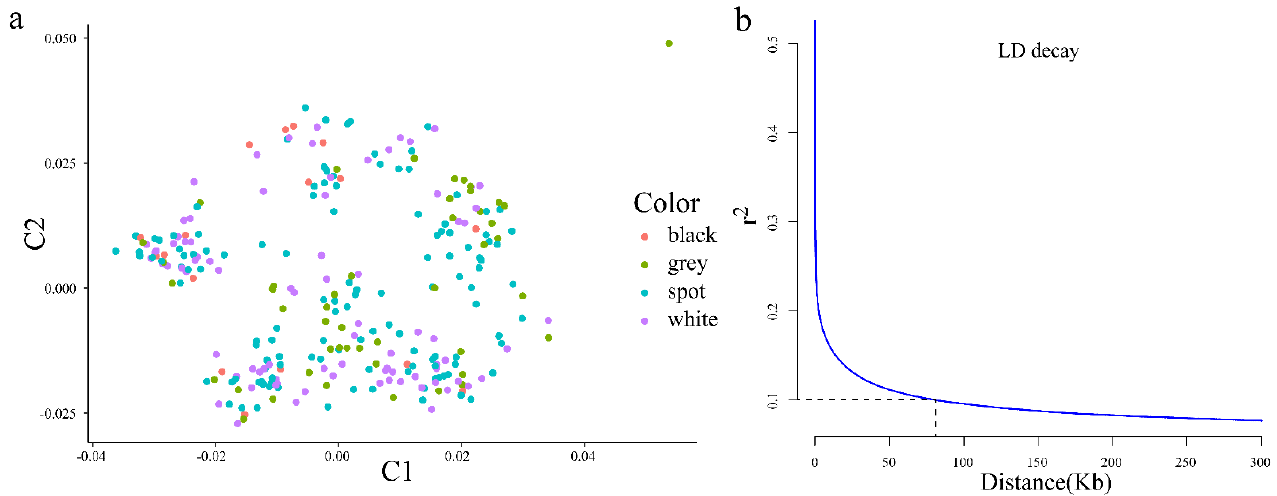
Figure 1. MDS plot ( a ) and LD decay plot ( b ) of F2 population by all SNPs.